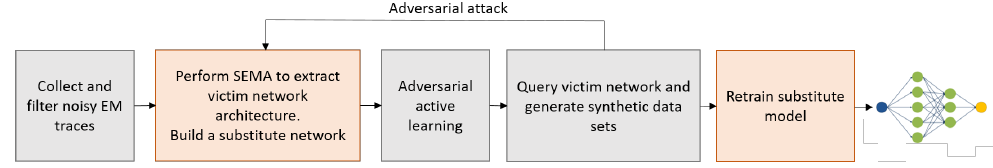
Figure 5. Overview of the attack proposed by Yu et al. [34] (artwork